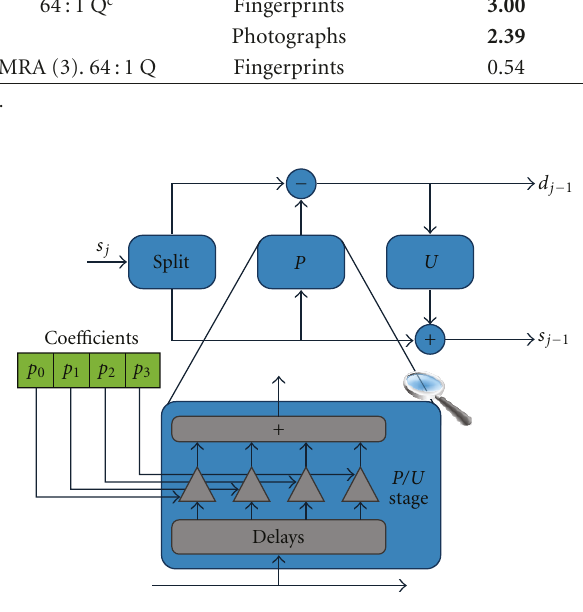
Figure 2: Idea of the